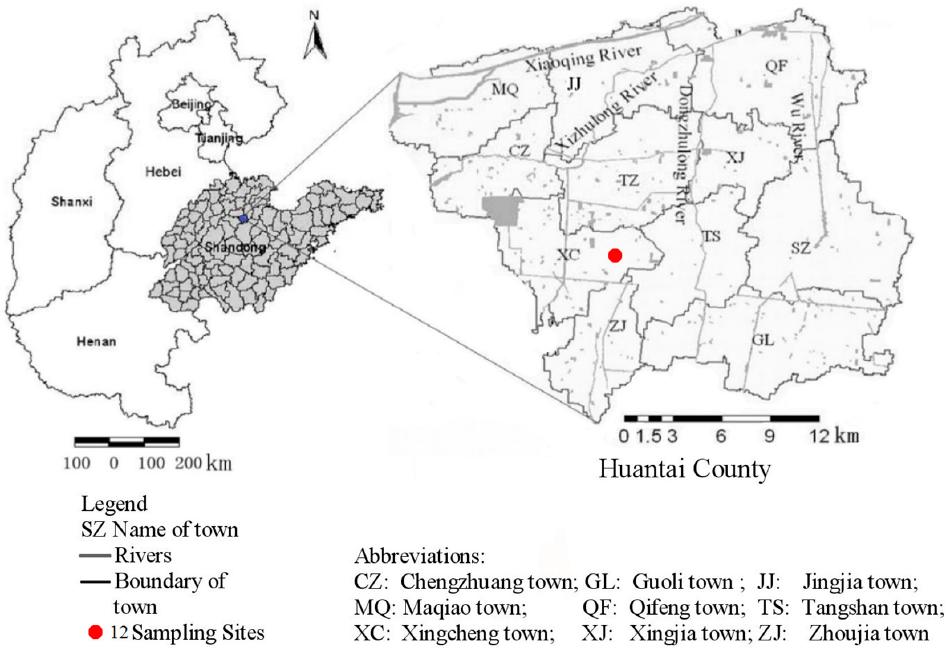
Figure 1. Location of the study area and the sampling sites.